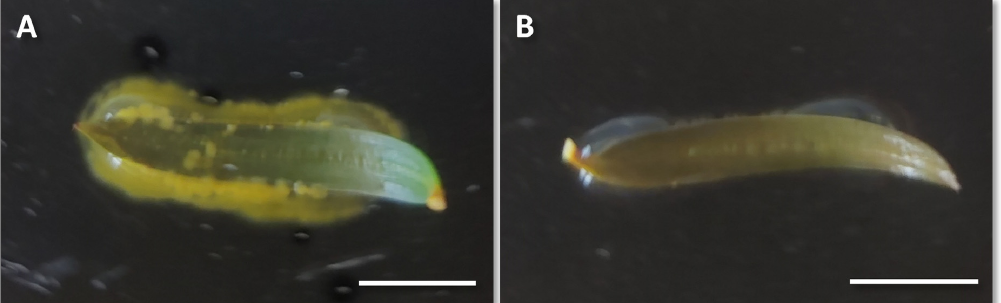
Figure 6. Needles inoculated by the liquid co-culture ex vitro method. ( A ) Contaminated needle. ( B ) Uncontaminated needle after 28 days of inoculation. Bars = 1.0 cm. ( B ) Uncontaminated needle after 28 days of inoculation. Bars = 1.0